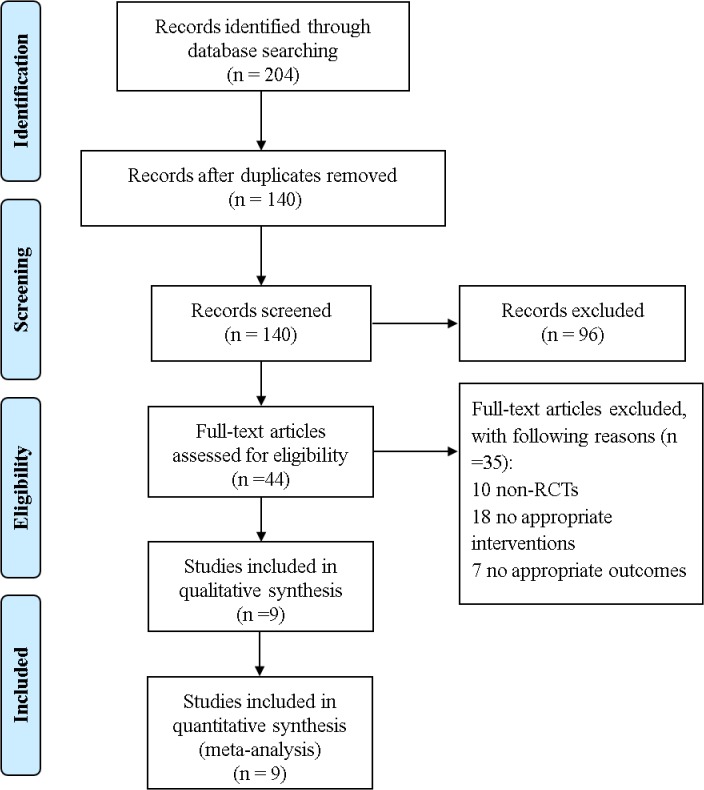
Flow Chart of Study Search and Selection.